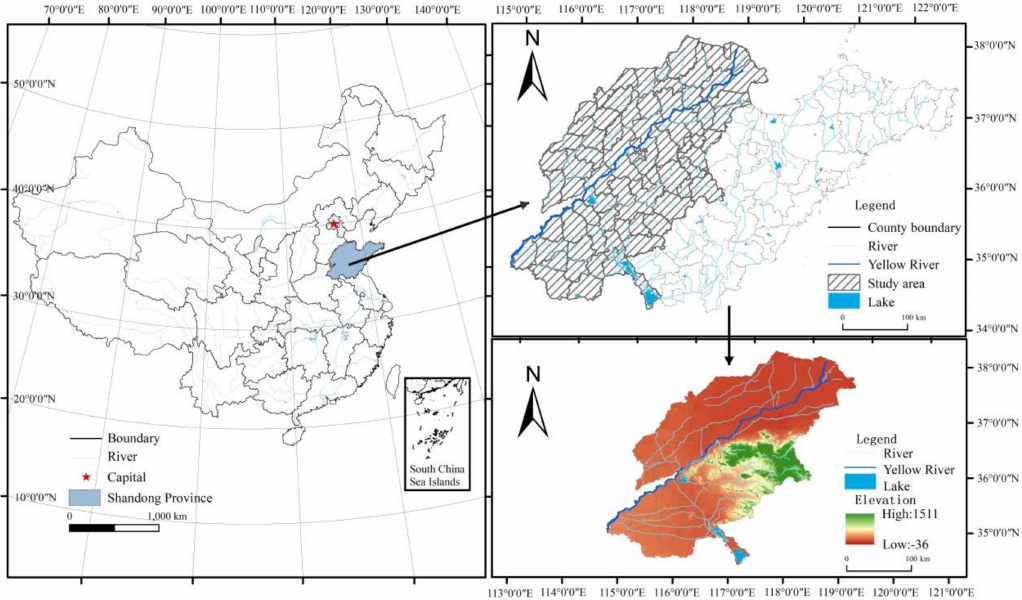
Figure 1. Location of the study